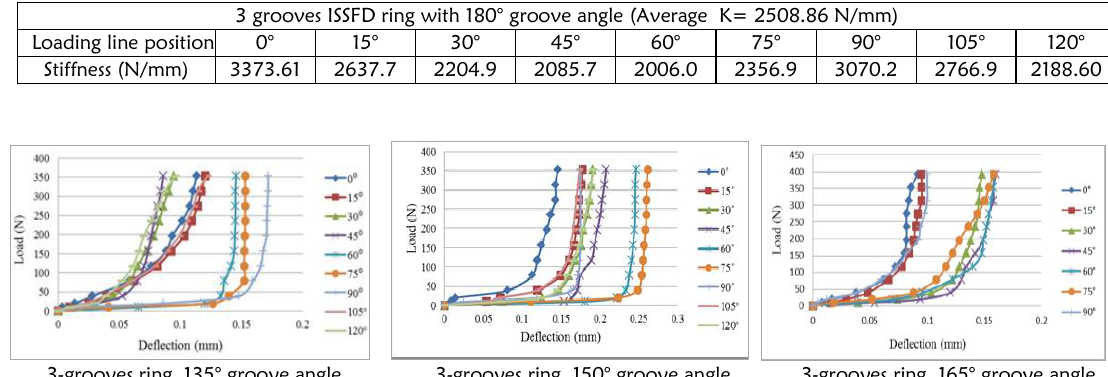
Figure 7a: Load v/s Deflection curves for 3- grooves ISSFD rings.